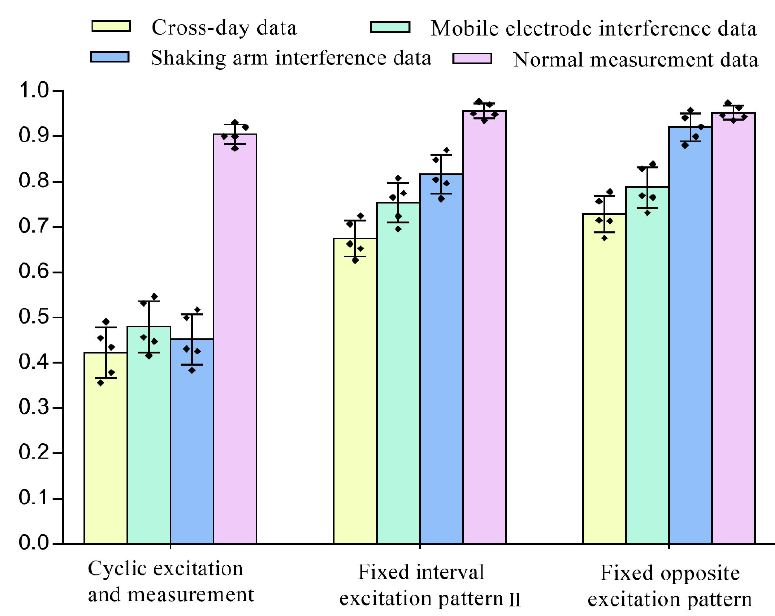
Figure 10. Classification results of normal data and interference data under different excitation patterns, the vertical lines depict the respective 95% confidence intervals, the black squares in the figure represent the distribution of sample points.